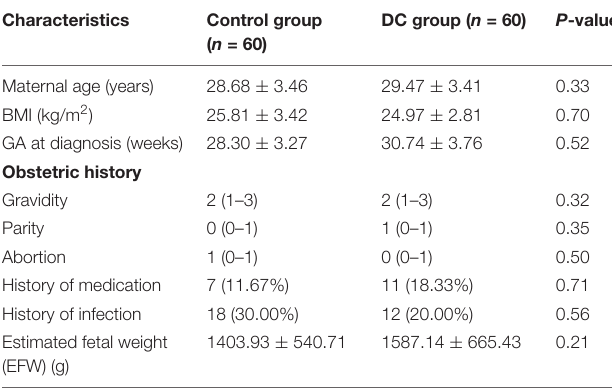
TABLE 1 | Baseline characteristics of the study